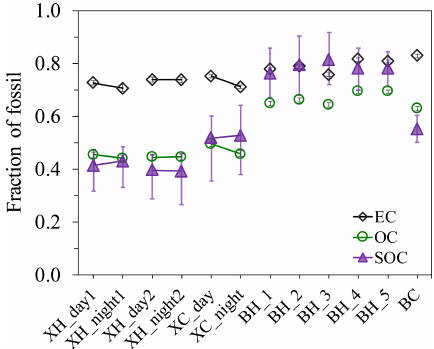
Figure 6. Fraction of fossil carbon in EC, OC, and SOC ( f fossil (EC), f fossil (OC), and f fossil (SOC), respectively) during haze and clean periods in Xi’an and Beijing. Interquartile ranges (25th–75th percentile) of the median f fossil (SOC) are shown as ver- tical bars in purple. Uncertainties of 14 C-apportioned f fossil (EC) and f fossil (OC) are indicated but are too small to be visible. The studied samples include day and night samples in Xi’an (X) and 24h integrated samples in Beijing (B) during haze periods (“H” samples) and clean periods (“C” samples). For details of each sam- ple ( x axis), see Fig. 1 and Table